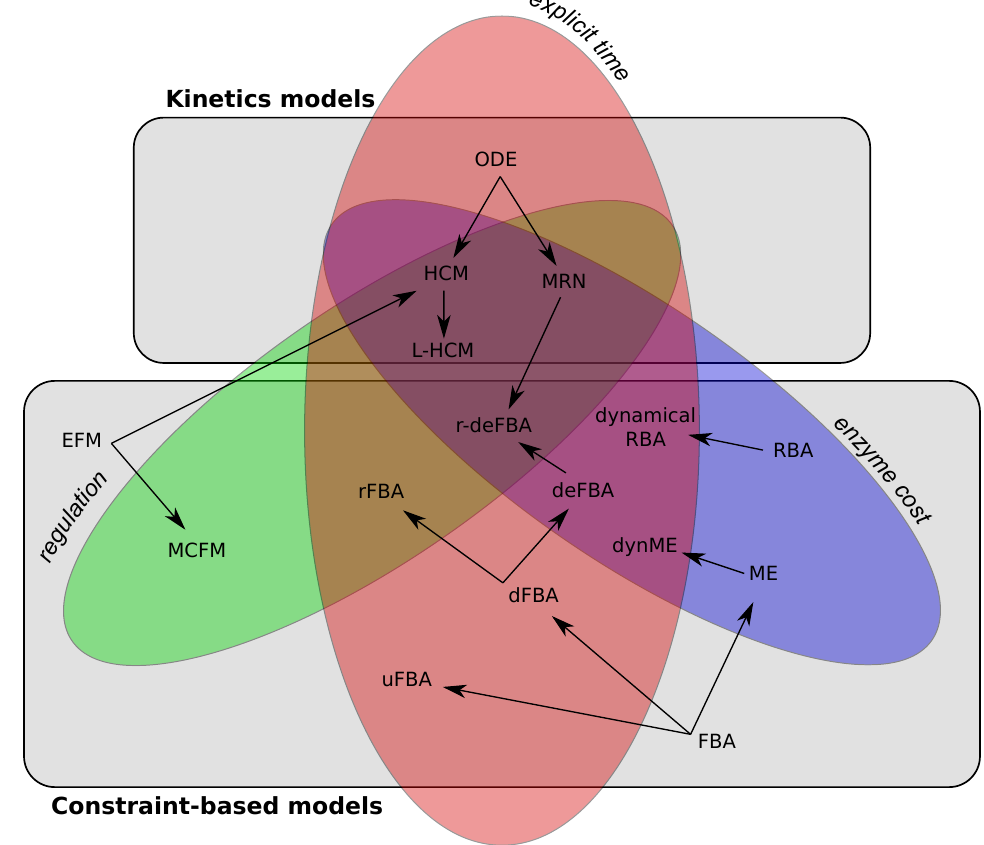
Figure 1. Graphical representation of the different frameworks evoked in this paper and their links. Each framework is categorised depending on its type: constraint-based or kinetic, and depending on some dynamical features it provides: explicit time, regulations or enzyme cost. An arrow from framework A to framework B indicates that B is an extension of